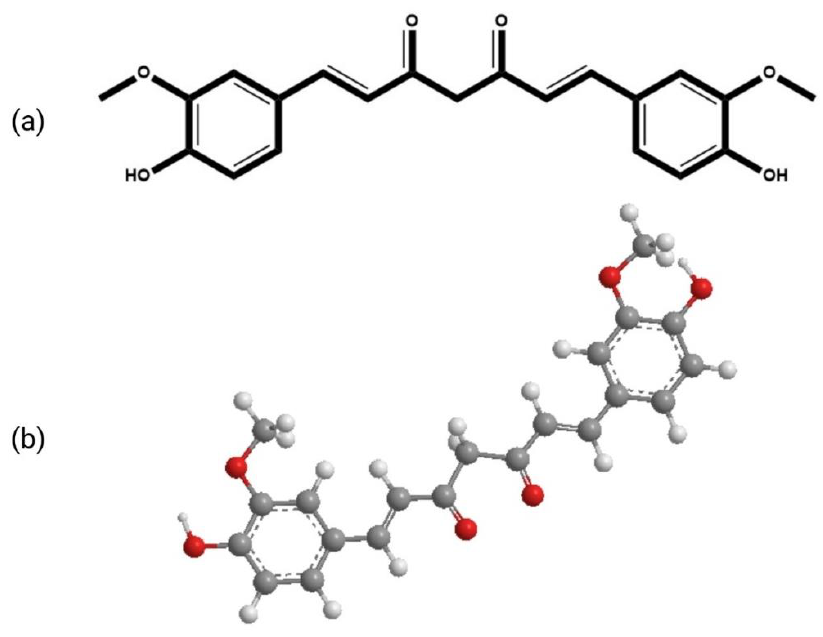
Figure 1. The chemical structure of curcumin ( a ) 2-D ( b ) 3-D .